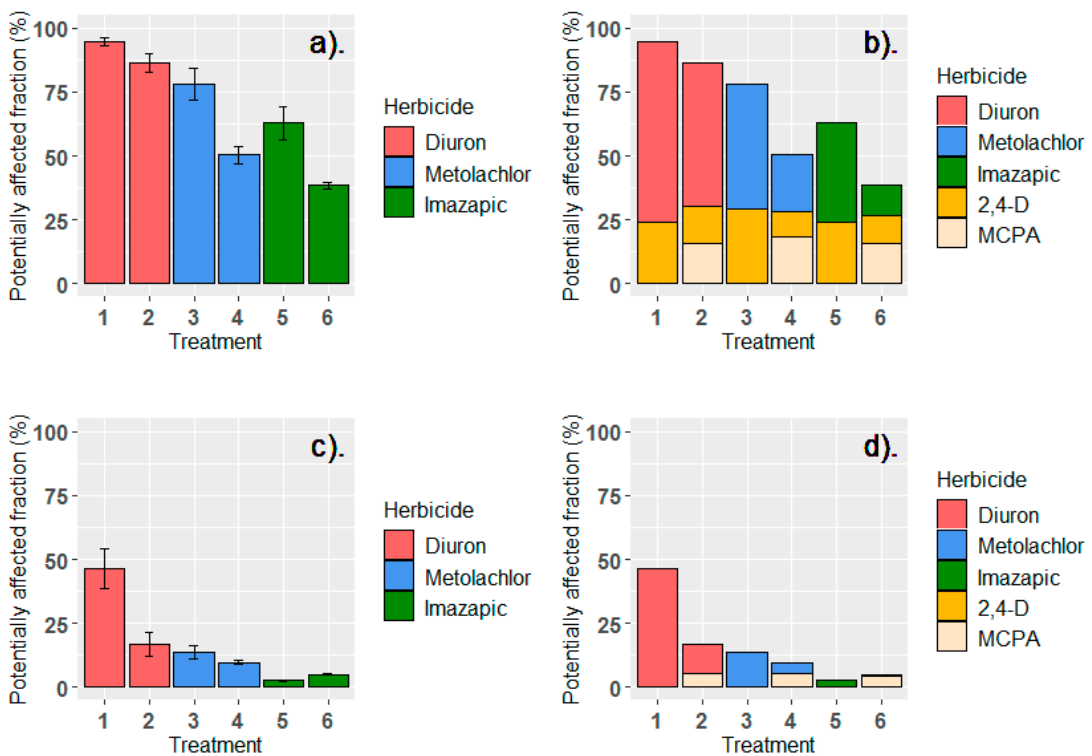
Figure 4. Average (±variance) multisubstance potentially affected fraction (PAF) metrics for event mean herbicide concentrations, leaving each irrigation treatment as surfacewater ( a ) total PAF for edge-of-field; ( b ) PAF contribution by individual herbicides at edge-of-field; ( c ) average (±variance) total PAF results upscaled (concentrations decreased 100 times) to concentrations similar to local water quality monitoring results; and ( d ) PAF contribution by individual herbicides at upscaled catchment concentrations. Treatments: 1—Diuron broadcast; 2—Diuron banded; 3—Metolachlor broadcast; 4—Metolachlor banded; and 5—Imazapic broadcast; 6—Imazapic banded.